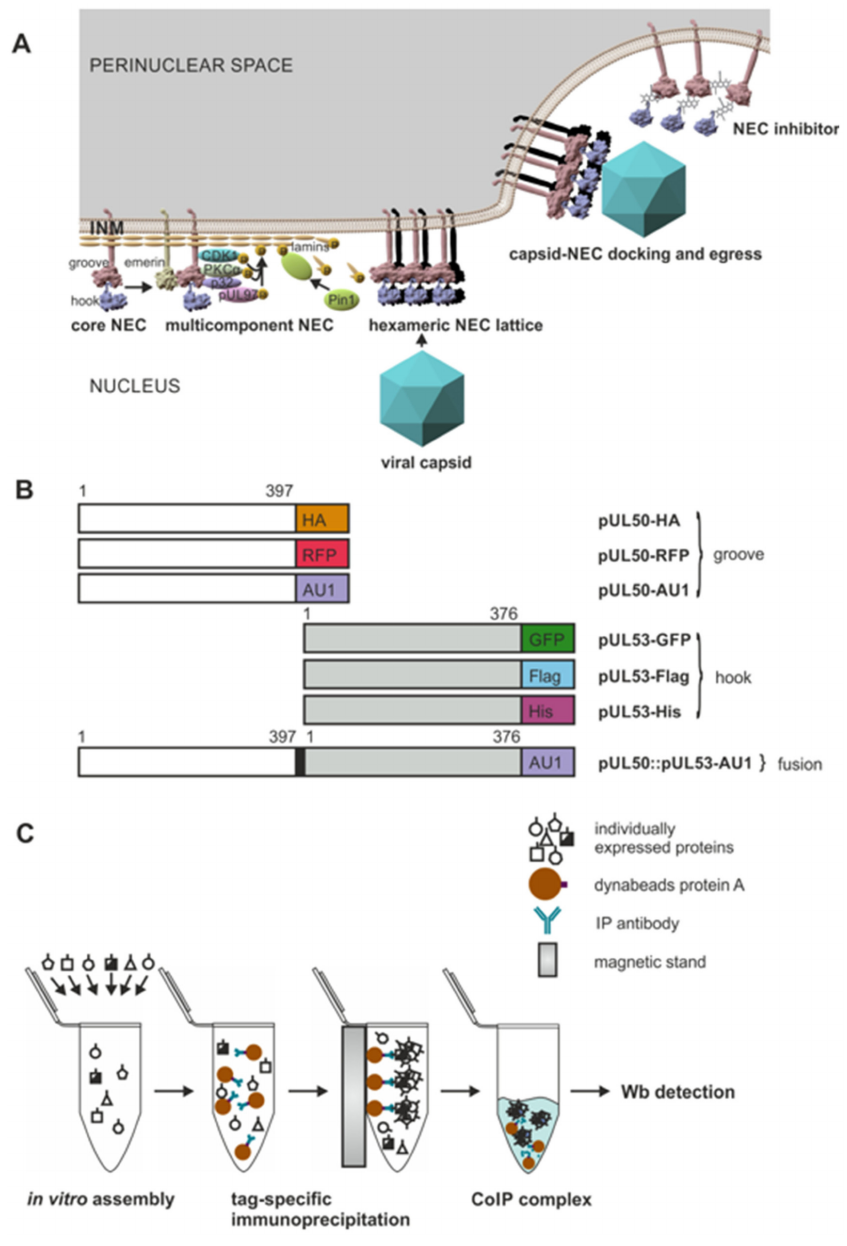
Figure 1. Schematic illustration of the functional role and approaches for analysis of the human cytomegalovirus (HCMV) core nuclear egress complex (NEC). ( A ) The core of the HCMV-specific NEC is built by the pUL50–pUL53 complex (termed as groove and hook proteins, respectively)